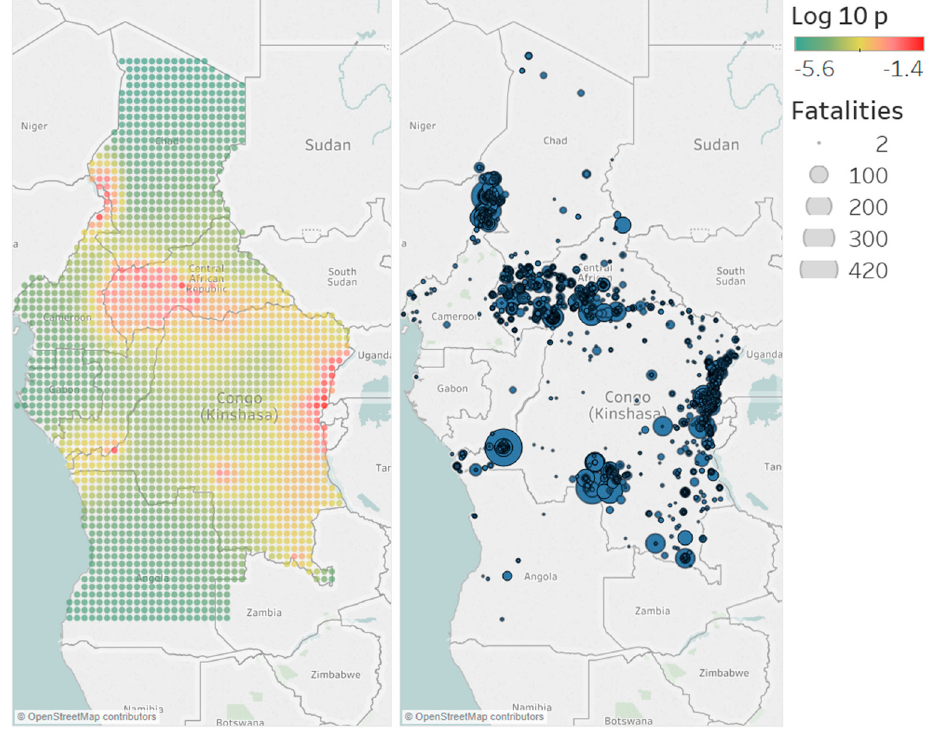
Figure 8. Spatial background distributions of the model with the largest log-likelihood for the region Central Africa. The area is divided into N c = 3330 cells. In these cells, the background intensity is assumed to be homogeneous. The cells give the probability of a background event occurring in that cell.